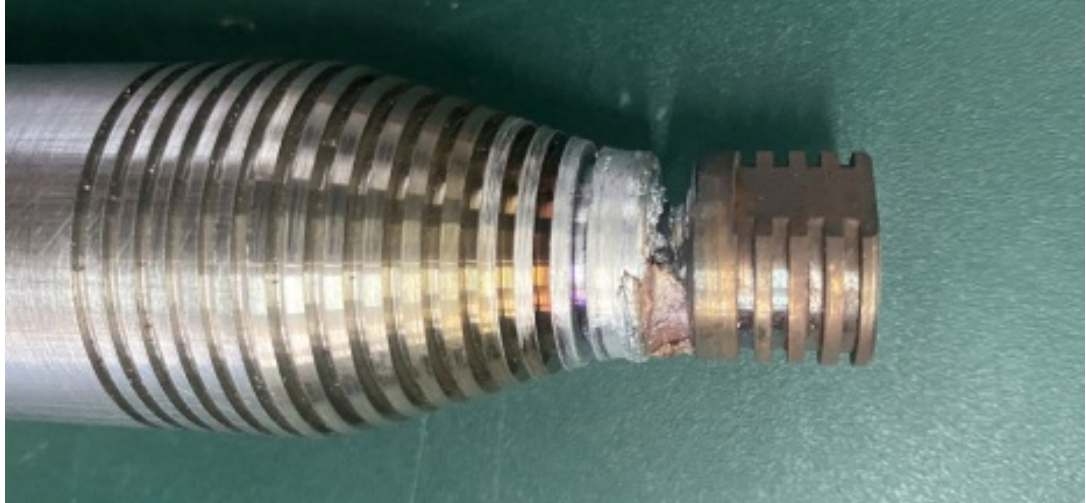
Figure 5. The phenomenon of the material adhesion in the tool.